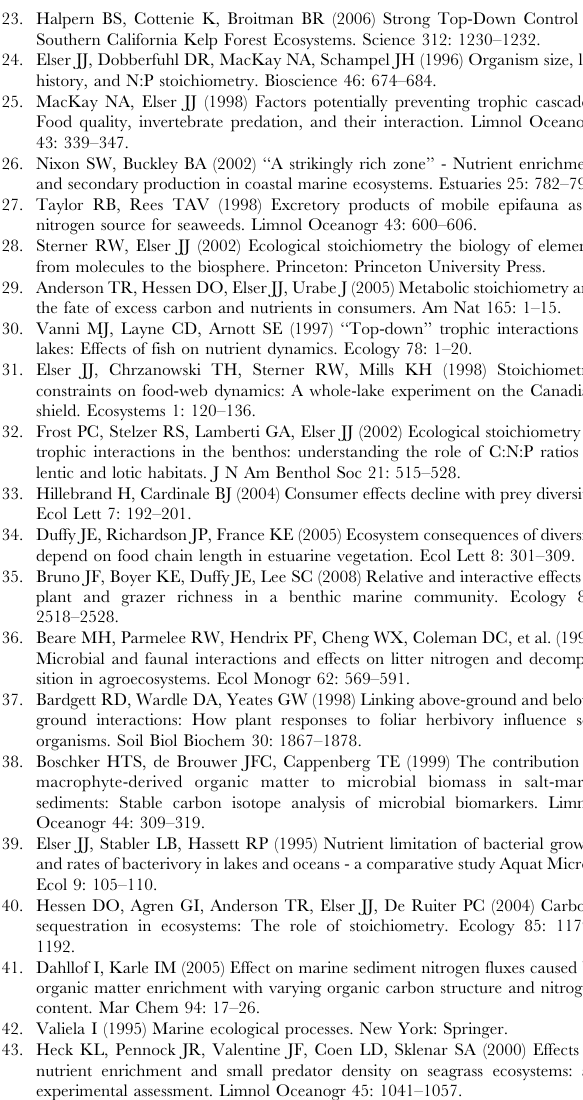
Table S1 Tests of significance and estimated magnitude of effects of nutrient enrichment, food chain length, and grazer species richness and their interactions on biomass, elemental ratios, and daily flux